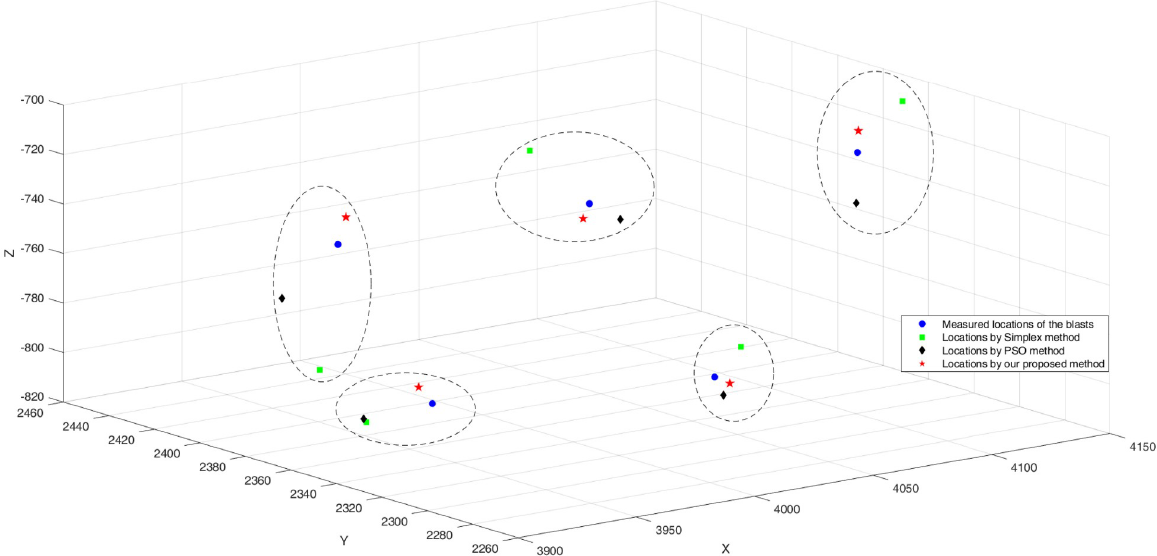
Fig 10. The location results for controlled blast experiments in five different locations. The actual locations of the blasts are marked with blue circles. Locations by Simplex, PSO and our proposed method are marked with green squares, black diamonds and red pentagrams.